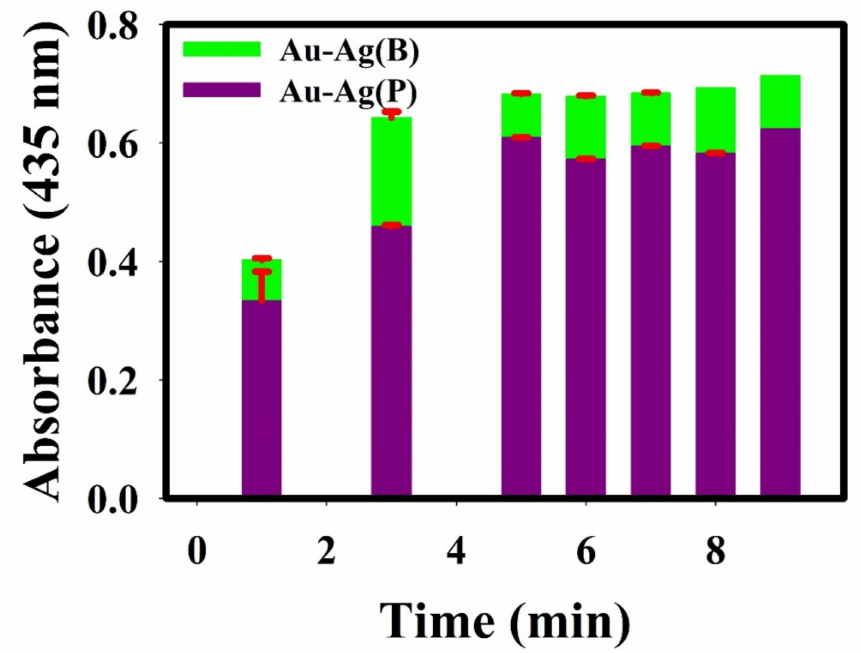
Figure 7. Effect of incubation time for determination of MOR using Au@Ag NPs (condition: pH = 6.5 ± 0.5, MOR conc.; 70 µ